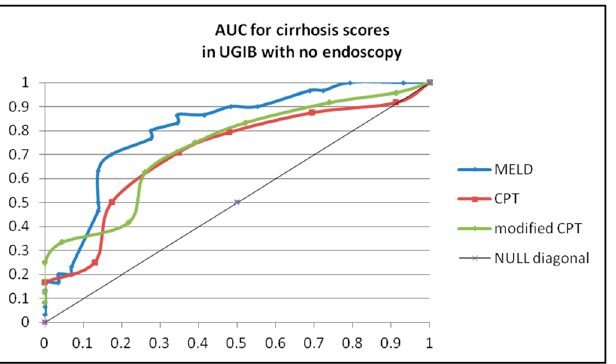
Figure 2. Area under curve for MELD, Child–Pugh–Turcotte and modified Child–Pugh–Turcotte (including creatinin level).